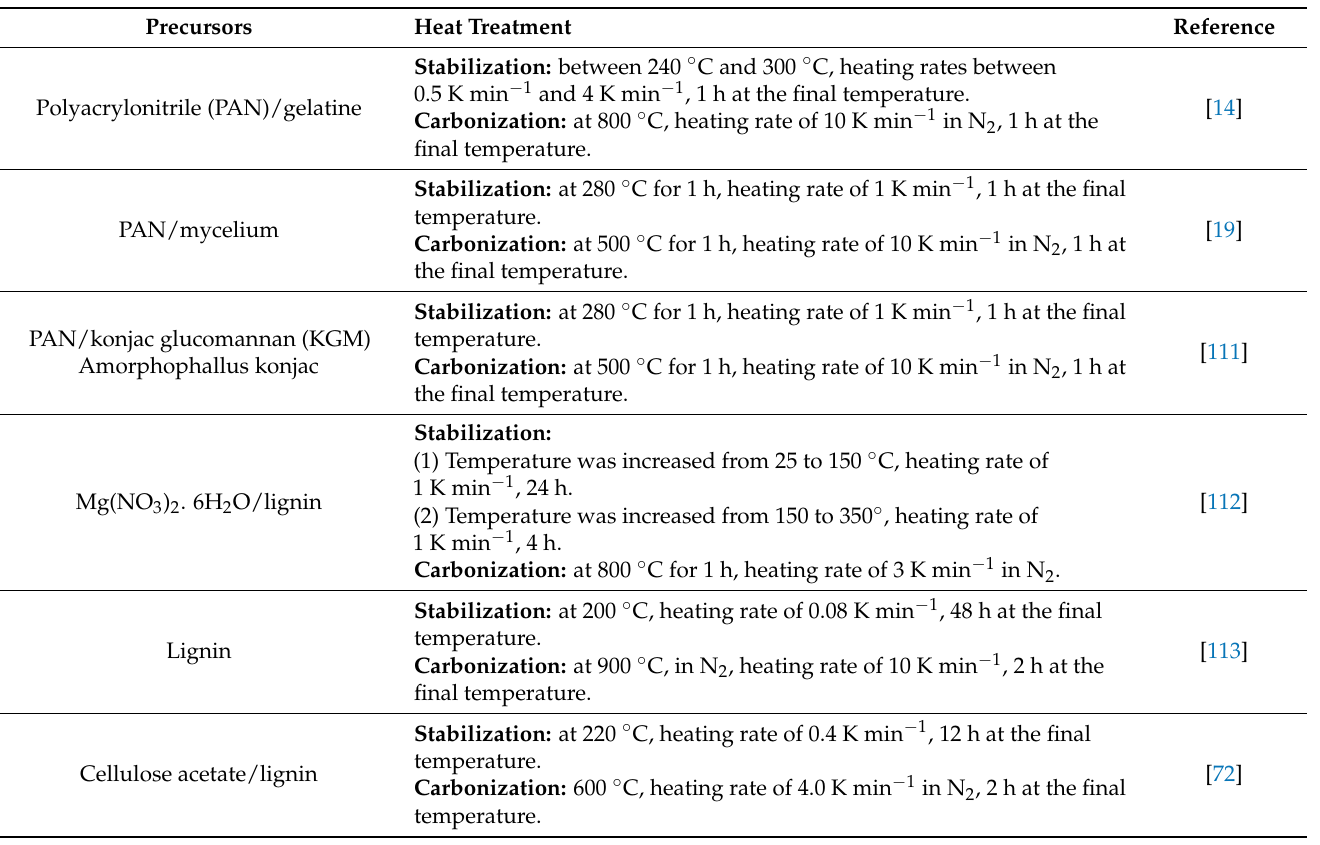
Table 1. Isothermal treatment conditions of biomass-derived electrospun carbon nanofibers. Precursors Heat Treatment Reference Polyacrylonitrile (PAN)/gelatine